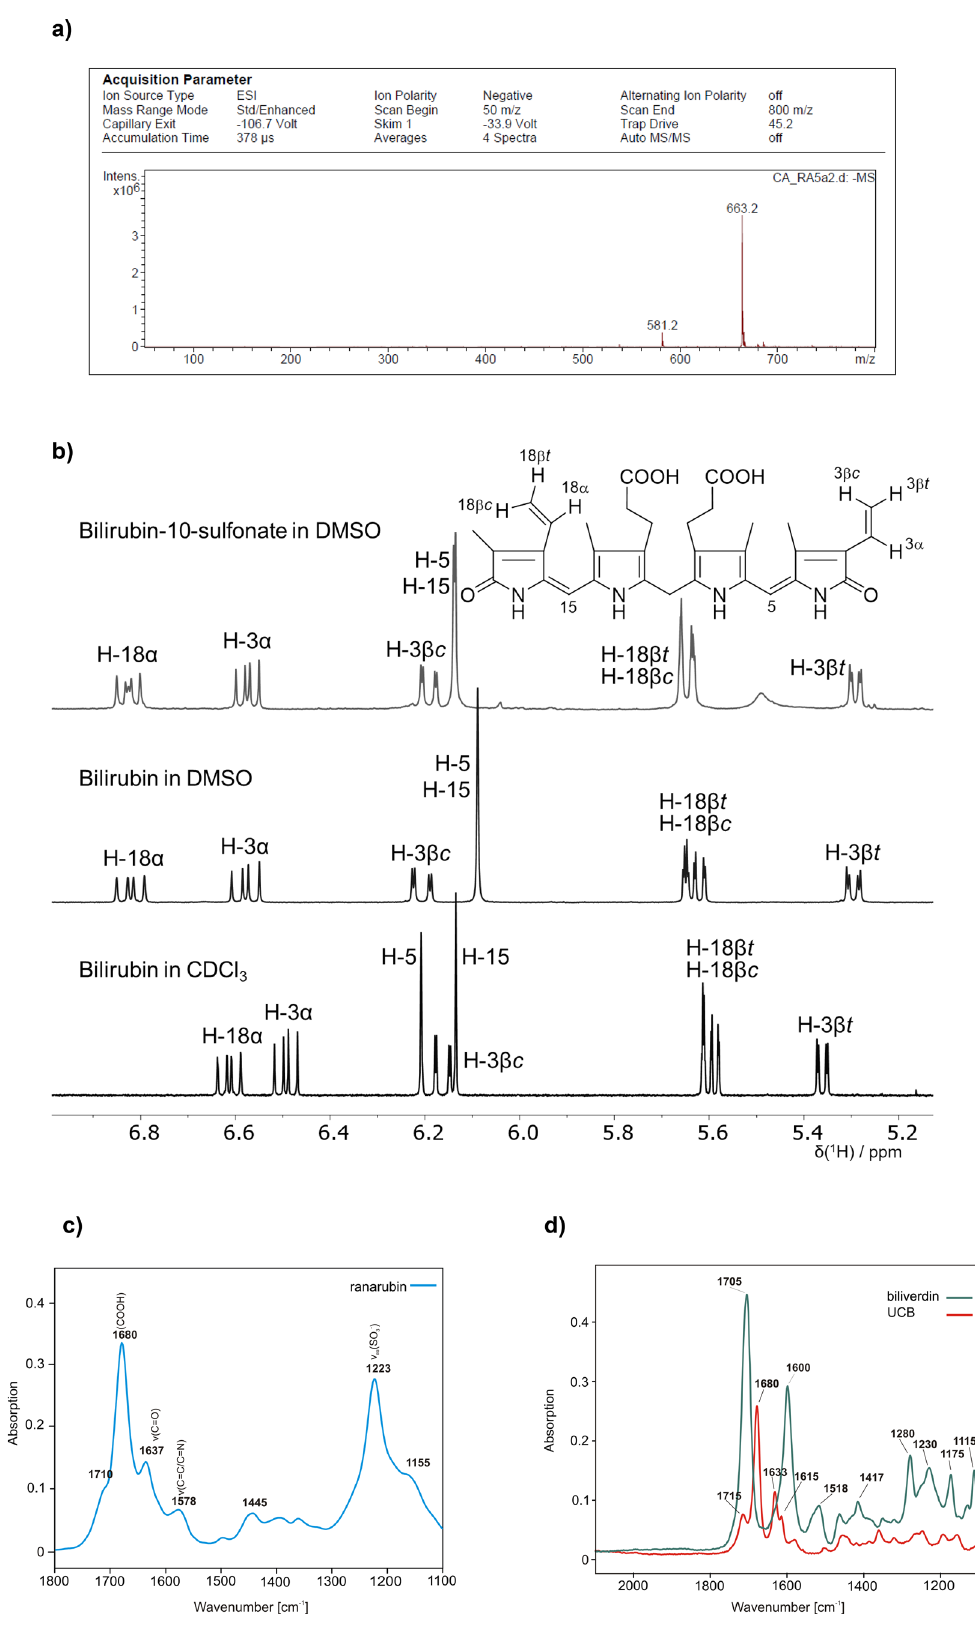
Figure 2. ( a ) Mass spectra of synthesized bilirubin-10-sulfonate (ranarubin); ( b ) The double-bond region of 1 H NMR spectra of UCB and bilirubin-10-sulfonate; IR spectra in DMSO of ( c ) bilirubin-10-sulfonate (c = 0.044 mol/L, pathlength = 50 μm); and ( d ) biliverdin and UCB (0.075 mol/L, pathlength = 25